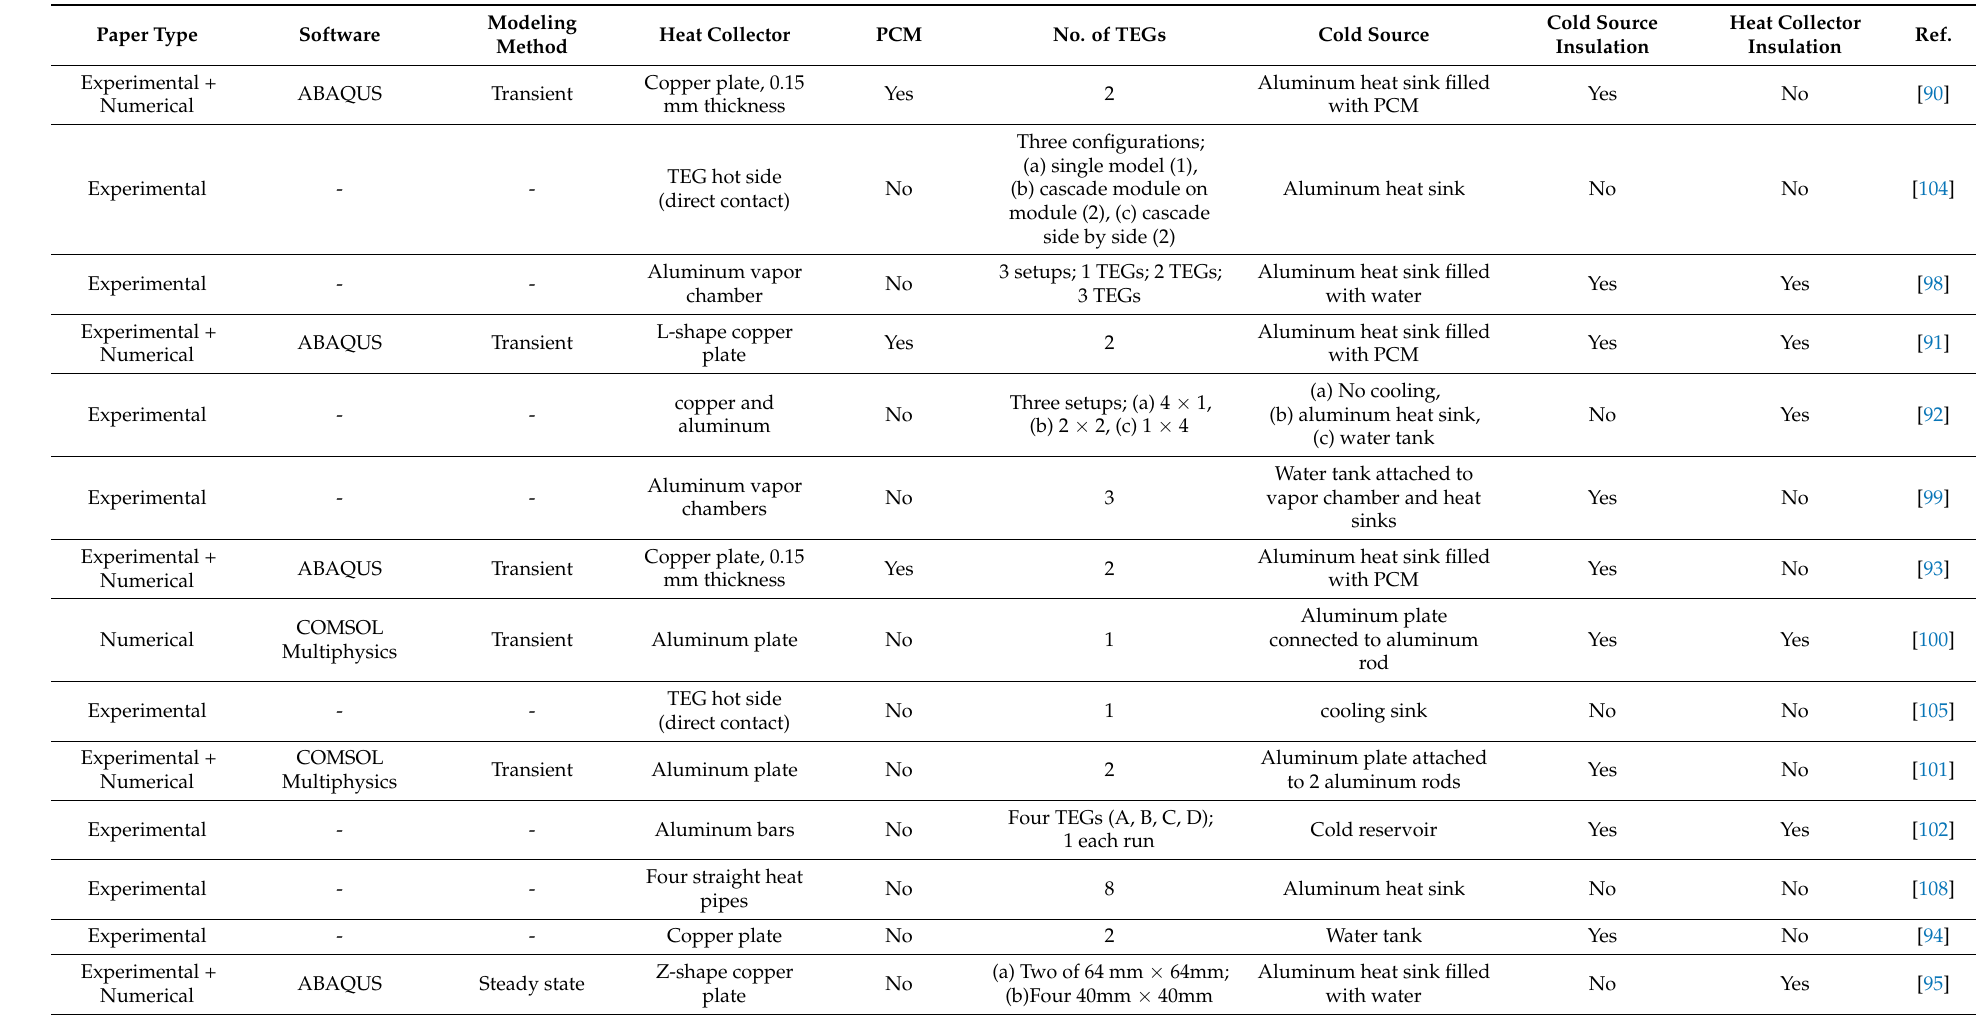
Table 5. Summary of the Previously Published Studies Using the TEG